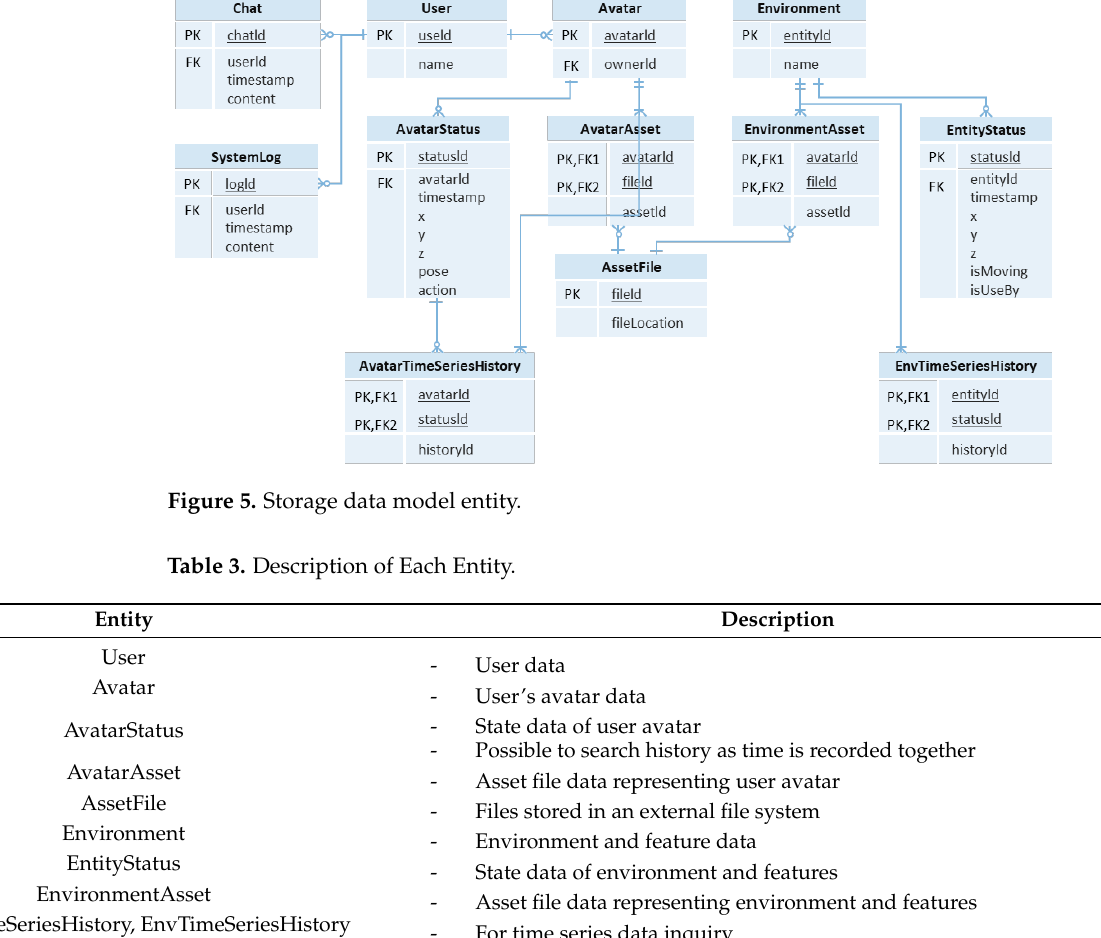
Figure 4. Storage data model. Table 3. Description of Each Entity.